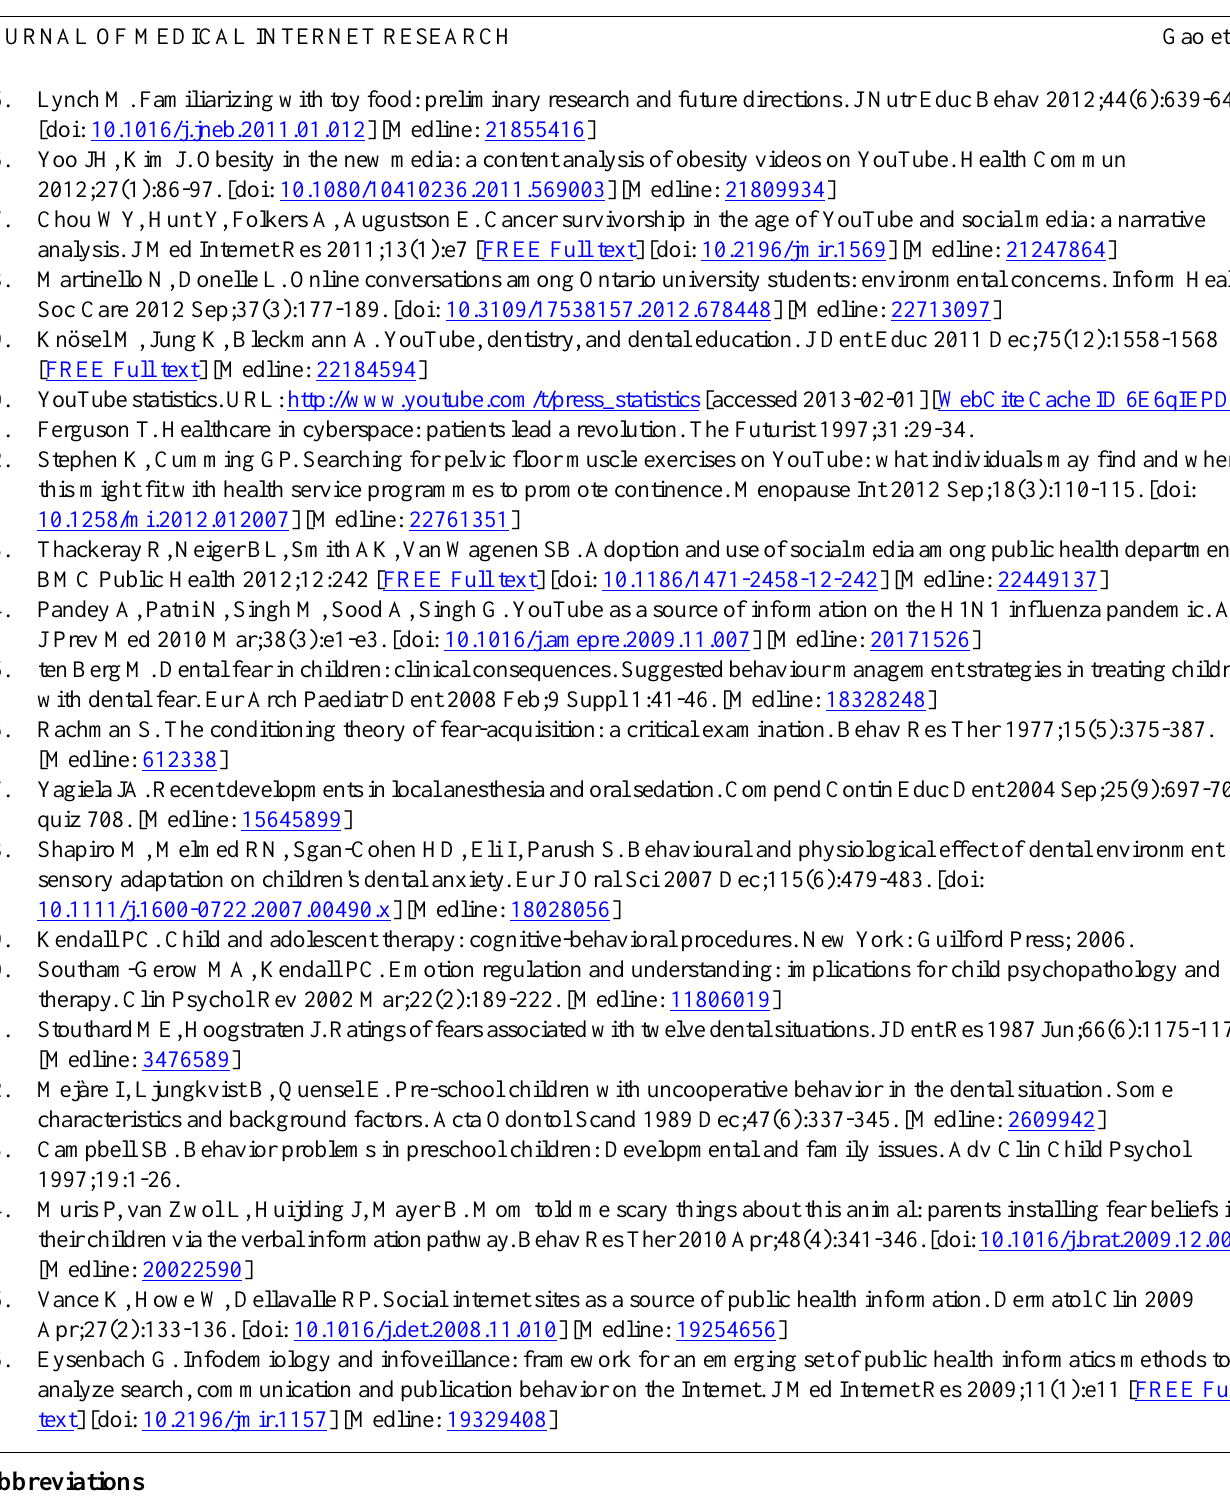
DFA: dental fear and